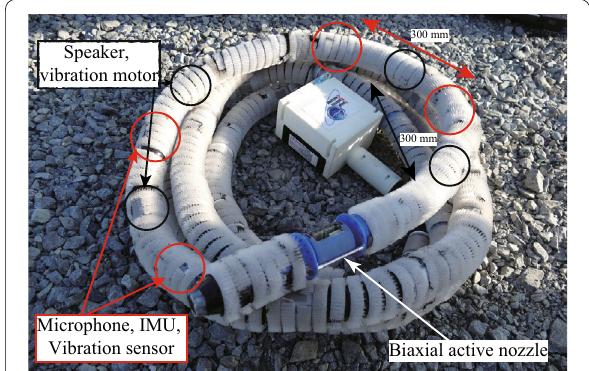
Fig. 2 ASC with various sensors, IMUs, microphones, speakers, and vibration sensors distributed on the robot’s body, and a high-speed camera mounted at the tip. An air-jet nozzle is also mounted at the tip, and a cilia-vibration-driving mechanism is mounted across the body